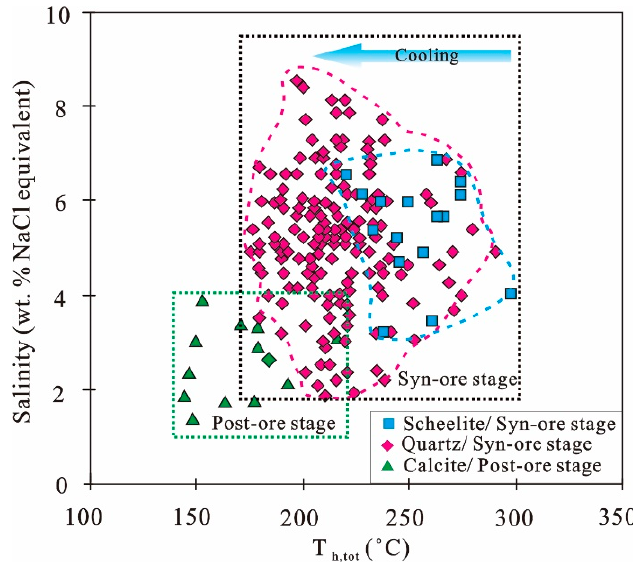
Figure 9. Covariation between homogenization temperature and salinity of fluid inclusions showing the evolution of the ore-forming fluids in the Shangfang W deposit.